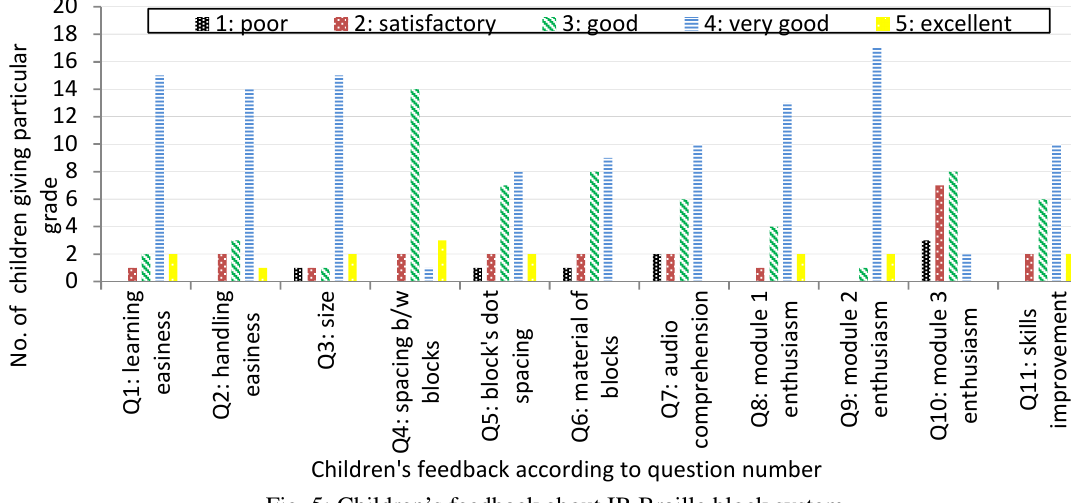
Fig. 5: Children’s feedback about IR Braille block system